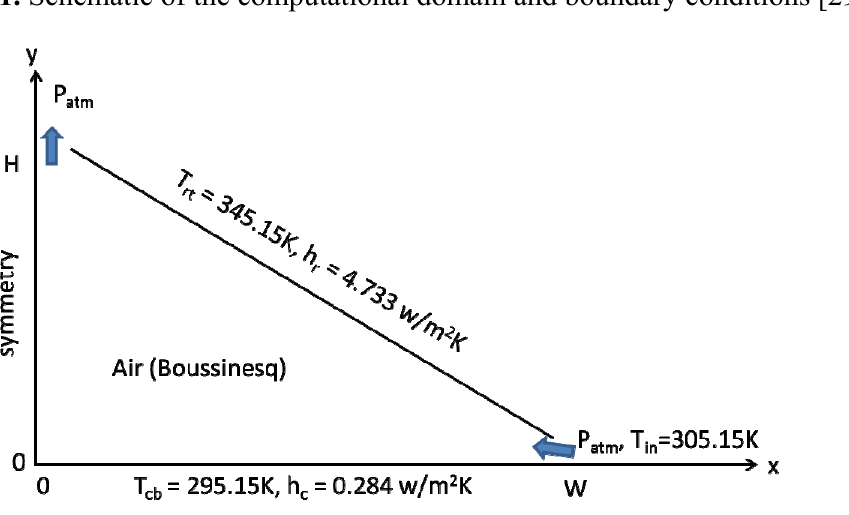
Figure 1. Schematic of the computational domain and boundary conditions